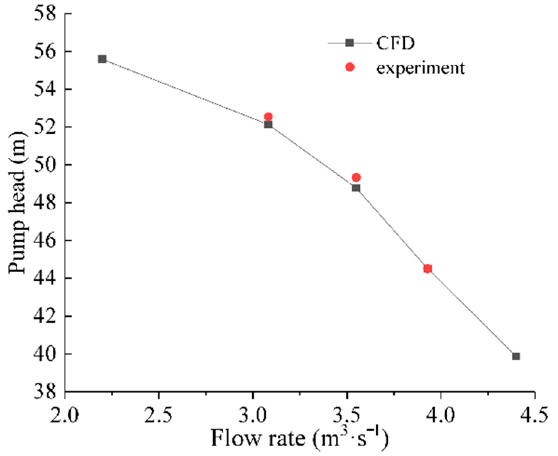
Figure 5. Change curve of pump head.